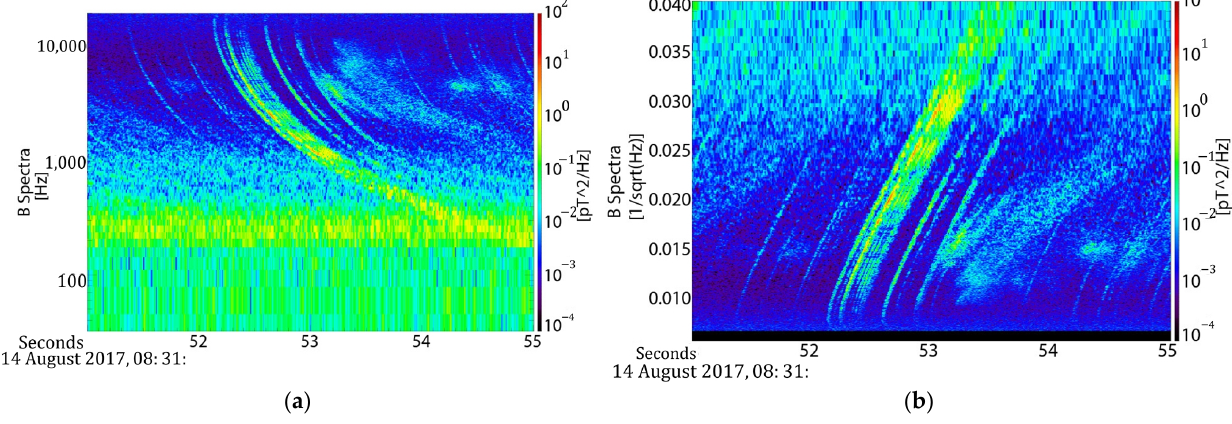
Figure 5. Lightning whistler observed by the Arase satellite on 14 August 2017 at 08:31:51–08:31:55 UT: ( a ) Dynamic power spectra of lightning whistler waves. ( b ) Converted dynamic power spectra of lightning whistler waves.